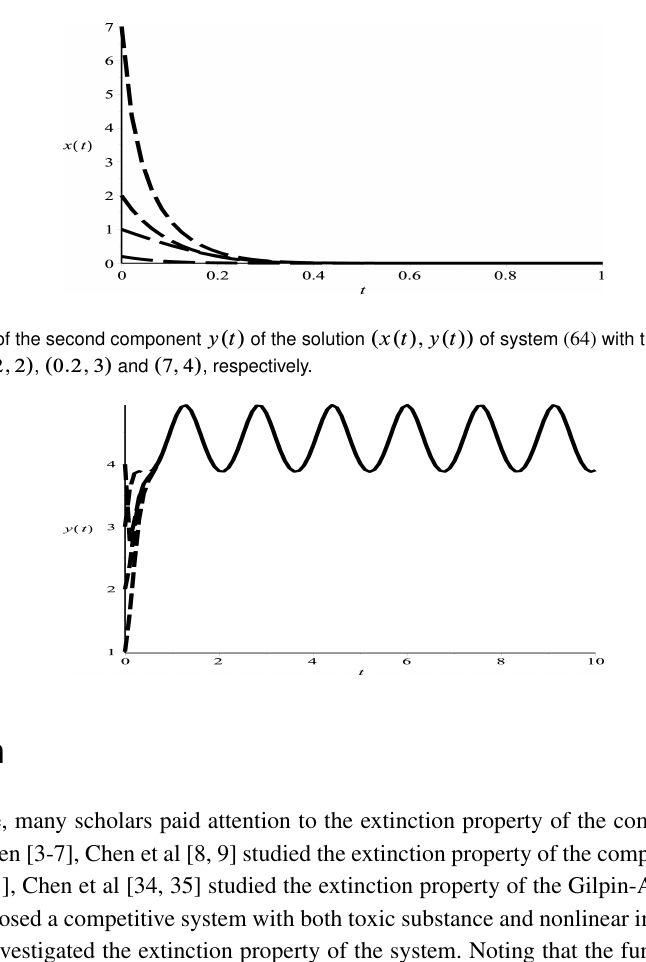
Fig. 5. Dynamic behavior of the first component x.t/ of the solution .x.t/;y.t// of system (64) with the initial conditions